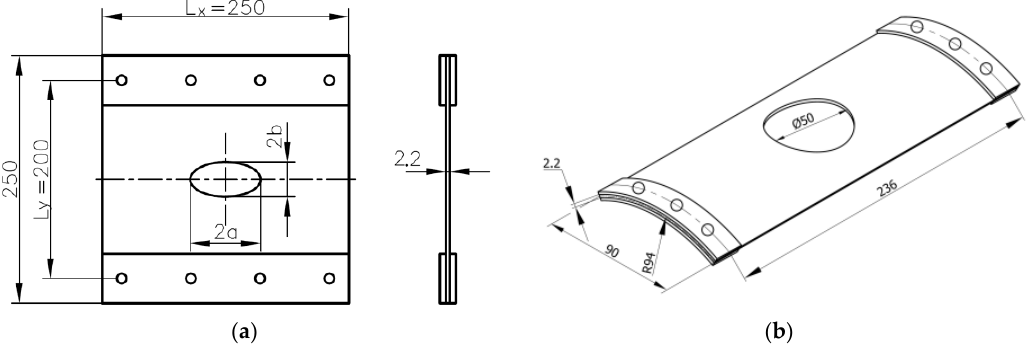
Figure 2. Dimensions (mm) of the specimens ( a ) and ( b ) used in the static and fatigue loading tests.